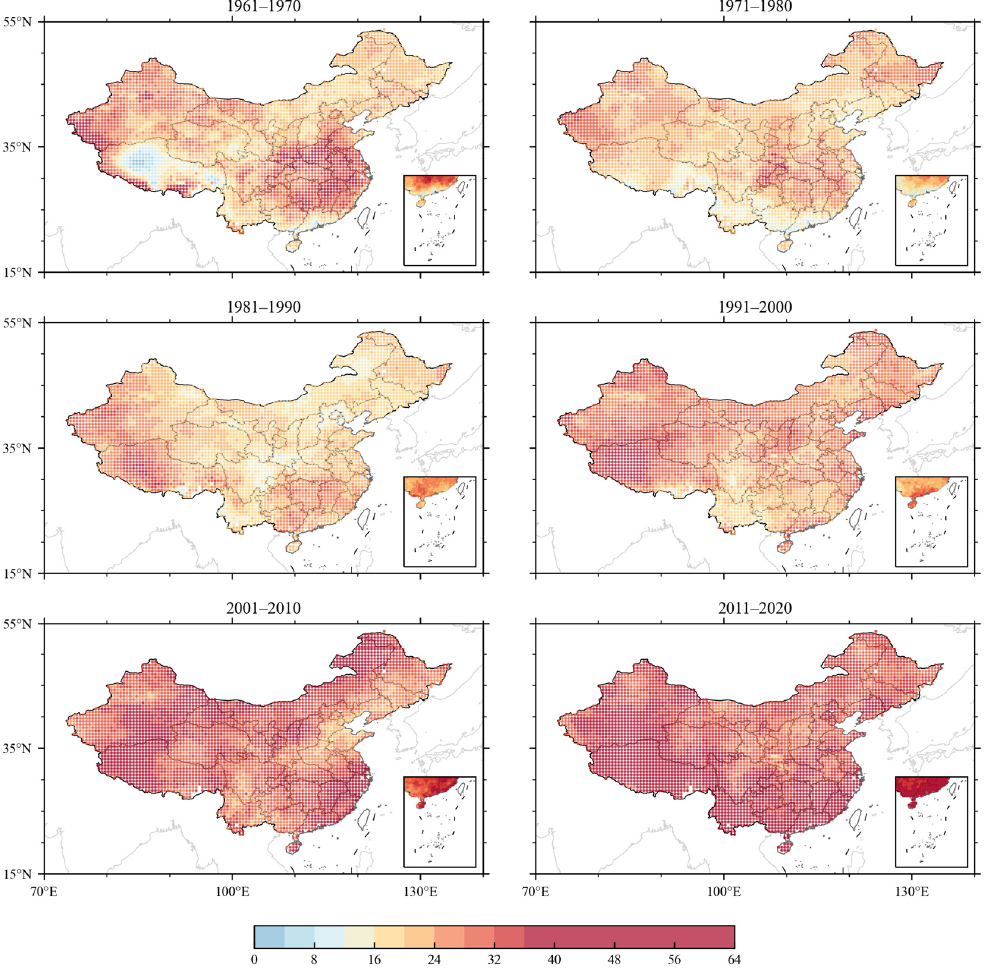
Figure 8. Distribution diagram of the decadal average duration days of heat waves based on PTM.